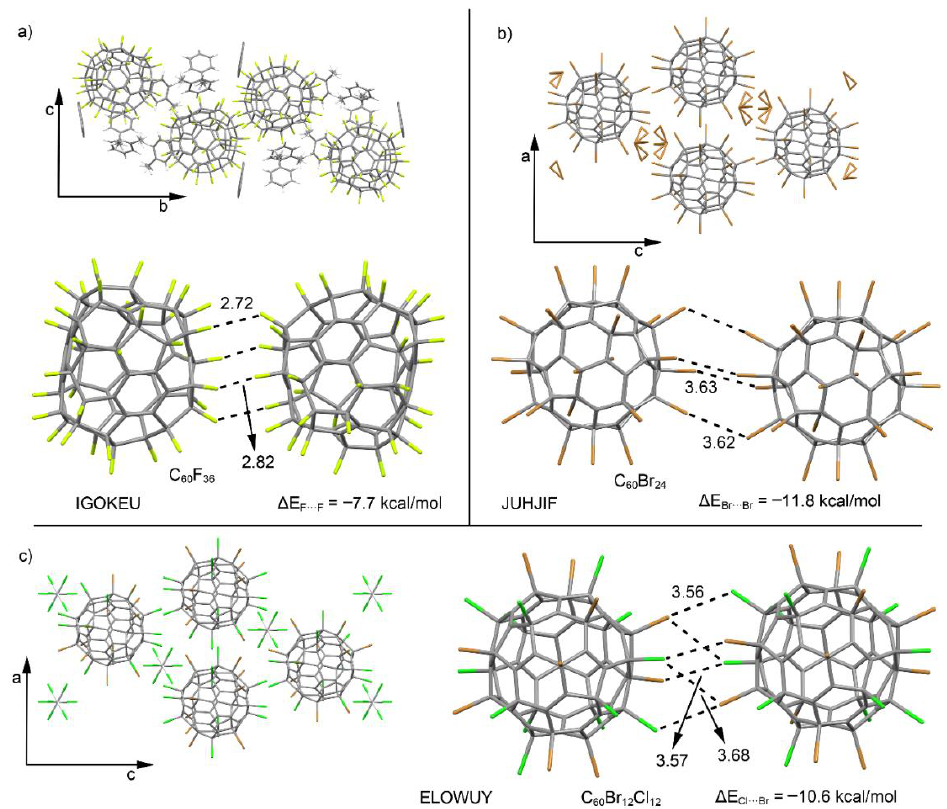
Figure 5. Partial views of the X-ray structure of some fullerene halides ( a ) C 60 F 36 , ( b ) C 60 Br 24 and ( c ) C 60 Br 12 Cl 12 . Distances in angstroms. The Cambridge structural database (CSD) codes are also indicated.